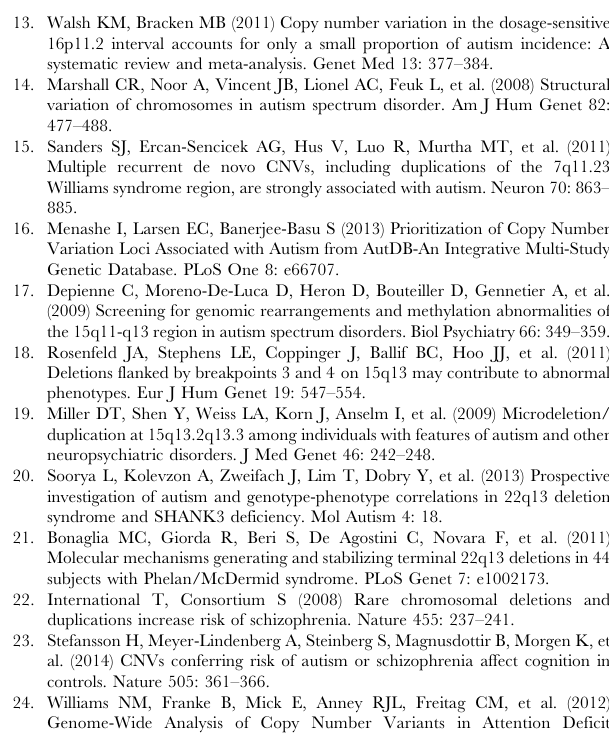
Table S1 Phenotypic characteristics of ASD individuals with CNVs at the 15q13.3, 16p11.2 and 22q13 regions. (XLS)